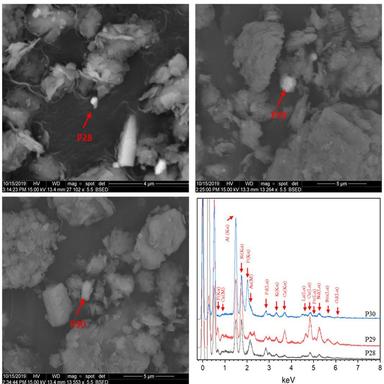
SEM-BSE images and EDX spectra of non-phosphate and enriched-phosphate particles found in SP25-R2.